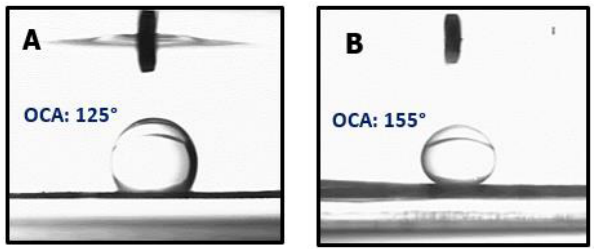
Figure 5. Underwater oil contact angle and oil droplet on ( A ) PAN and ( B ) PAN-1.5GO-7.5SiO 2 nanofiber membranes.